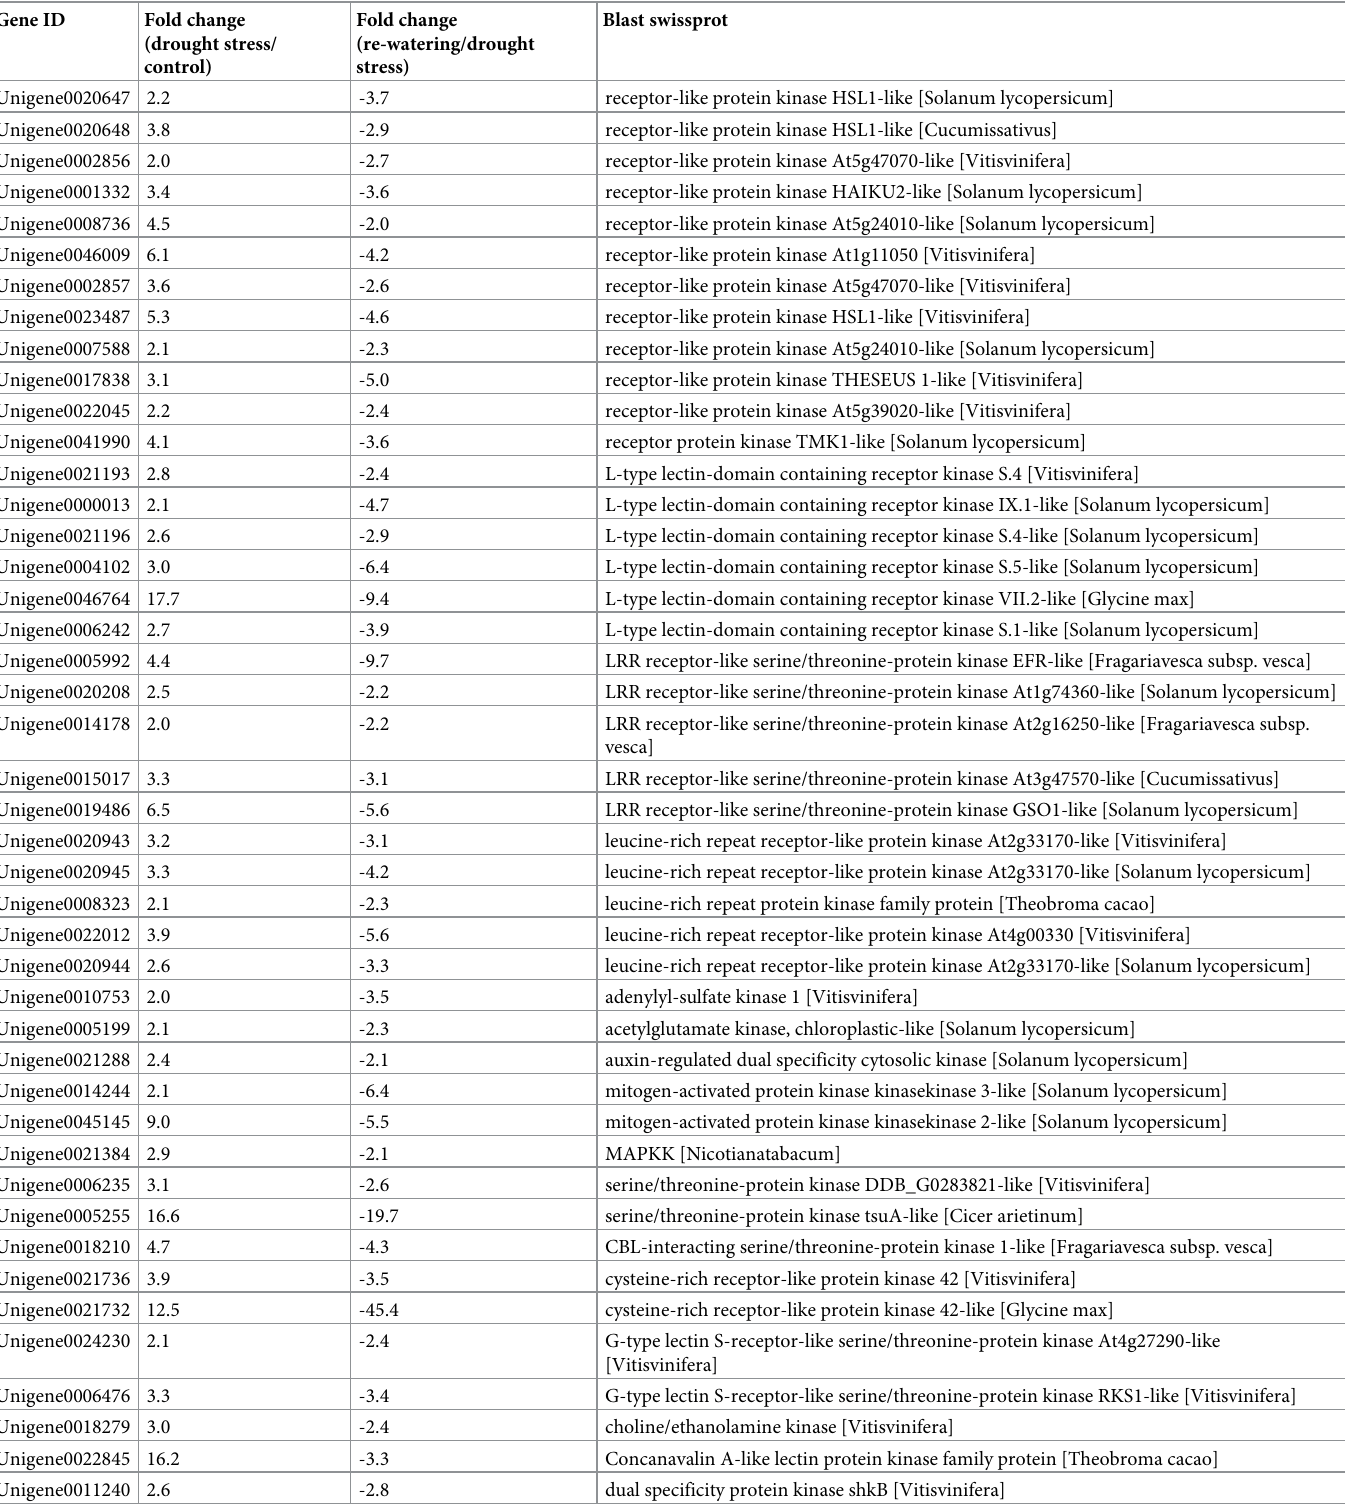
Table 4. The putative kinase encoding genes that were induced by drought stress and repressed by re-watering. Gene